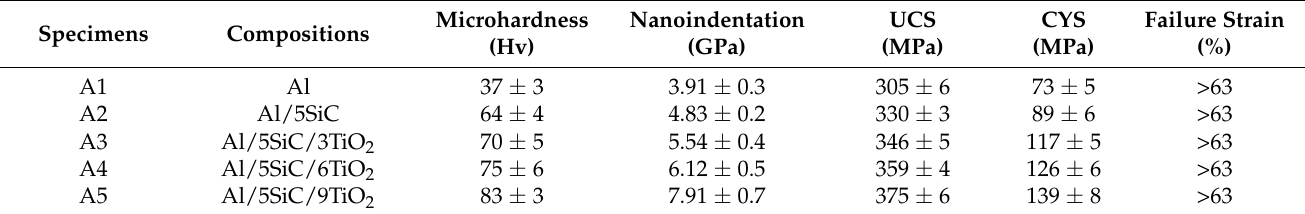
Figure 8. Vickers microhardness of the Al/SiC/TiO 2 hybrid nanocomposites and micrographs of the area indenter by the Vickers hardness tester in samples A2, A3, A4, and A5. Table 2. Hardnesses and compressive properties of Al/SiC/TiO 2 hybrid